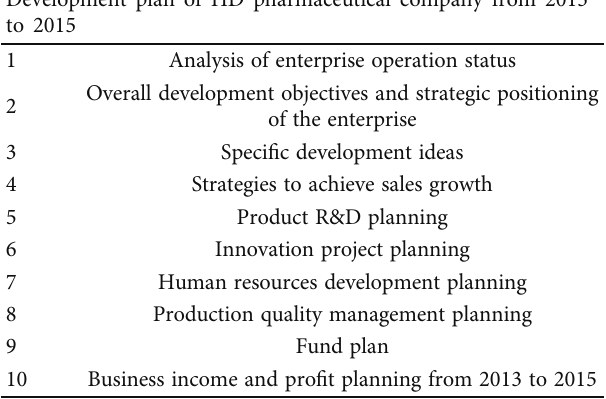
Table 4: Development plan for